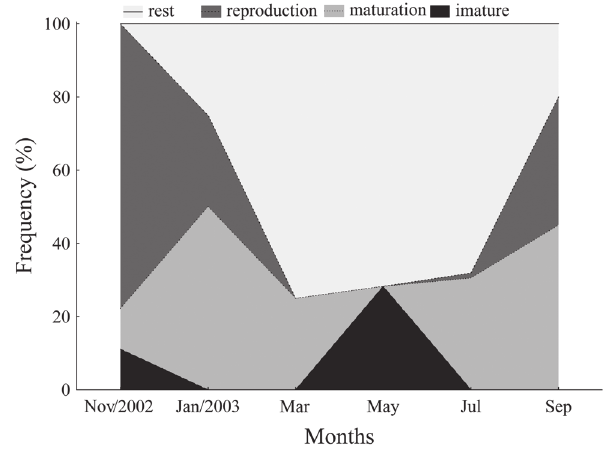
Fig. 7. Frequency of the gonadal development stage of Iheringichthys labrosus captured in the Piquiri River from November 2002 to September 2003.